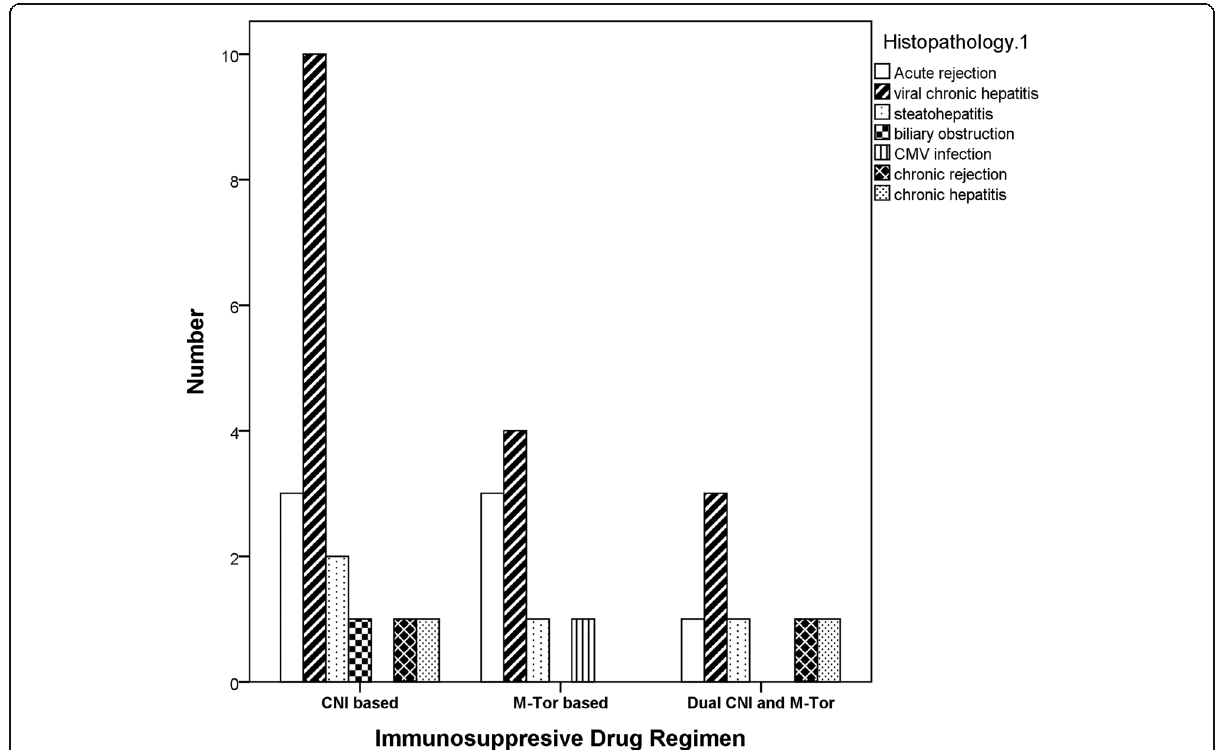
Fig. 4 Impact of the immunosuppressive drug regimen on the histopathology